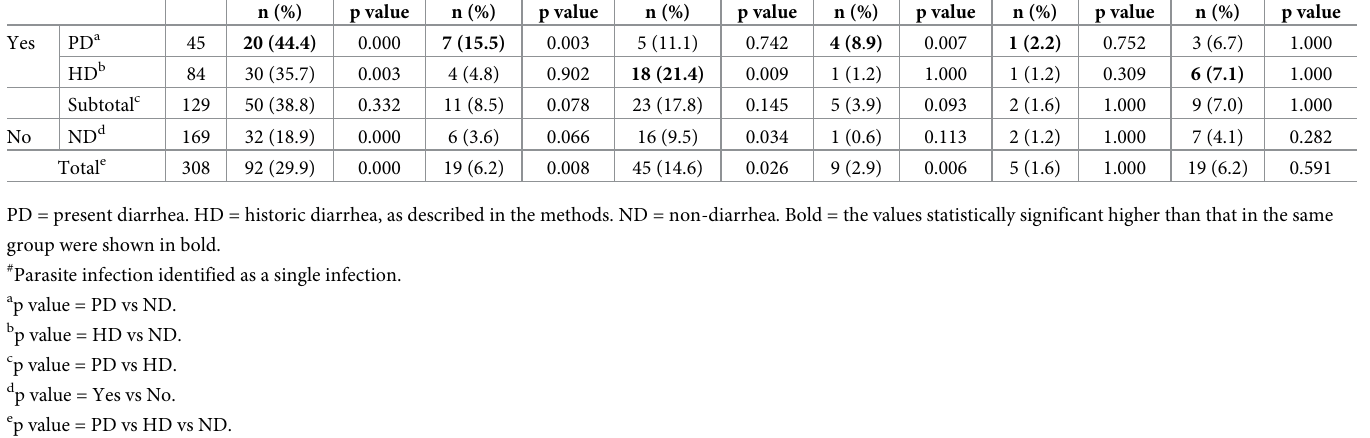
Table 4. Parasite infection proportion in MSM HIV-positive participants with different diarrhea status. Diarrhea status #